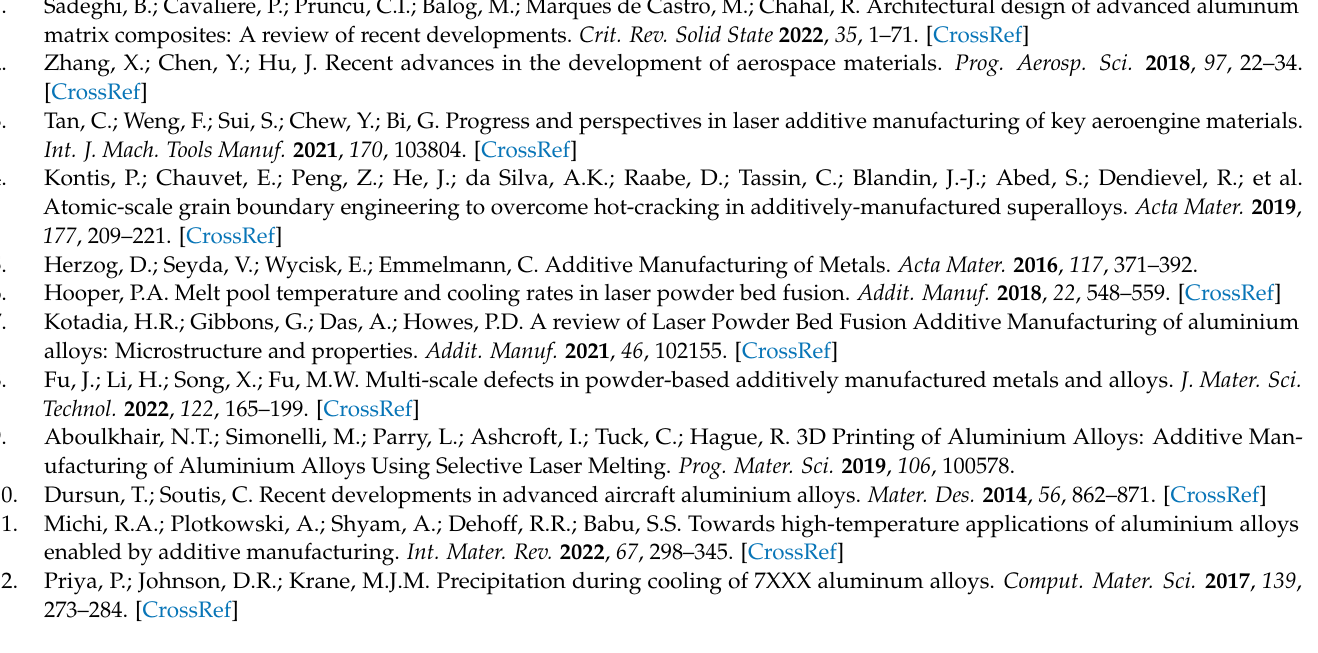
fabricated by SLM; Figure S5: Distribution of micropores in TiB 2 /AlZnMgCu(Sc,Zr) composite samples;. Figure S6: Phase analysis of AlZnMgCu(Sc,Zr) alloy and TiB 2 /AlZnMgCu(Sc,Zr) composite before and after heat treatment; Figure S7: HAADF image of the interface between micron-TiB 2 particle and Al matrix in SLM-fabricated TiB 2 /AlZnMgCu(Sc,Zr) composite (a) in relatively low magnification, (b)